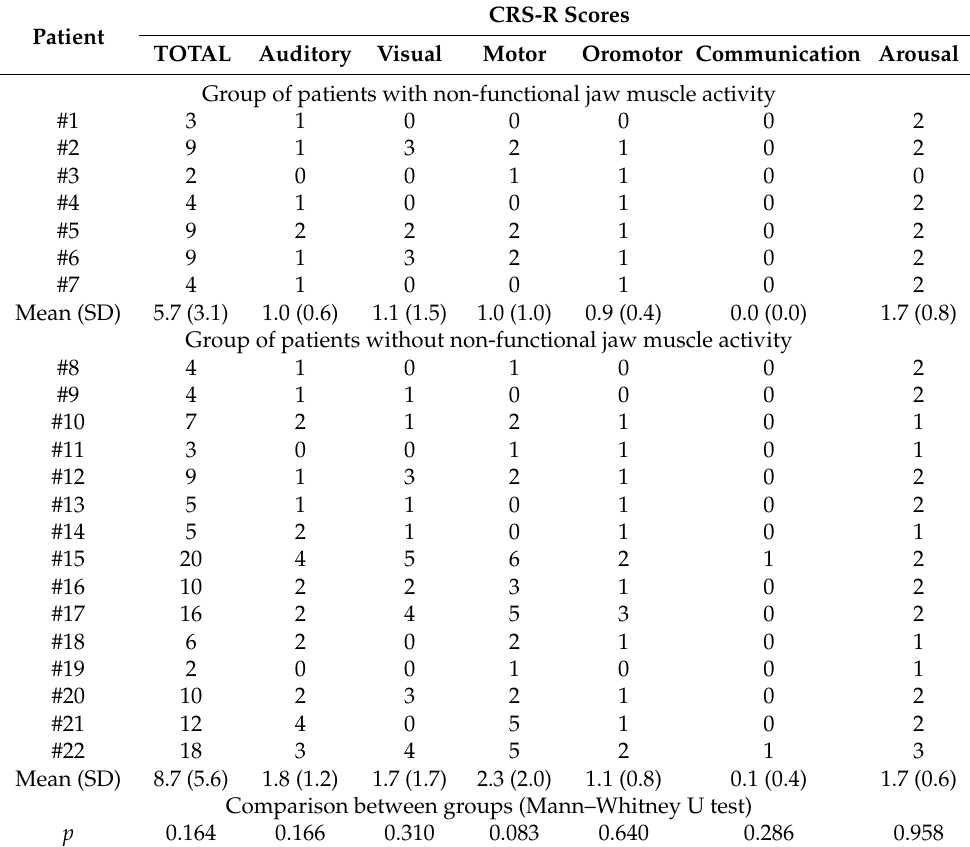
Table 2. CRS-r scores of the